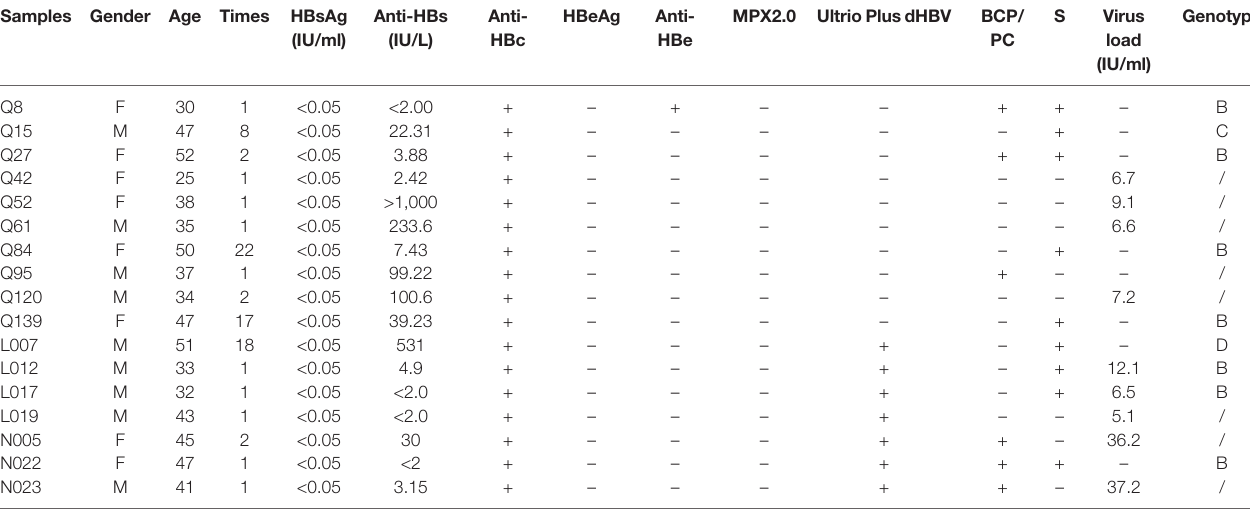
TABLE 2 | The serological and molecular characterization results of the 17 identi fi ed HBV DNA+ donations. Samples Gender Age Times HBsAg